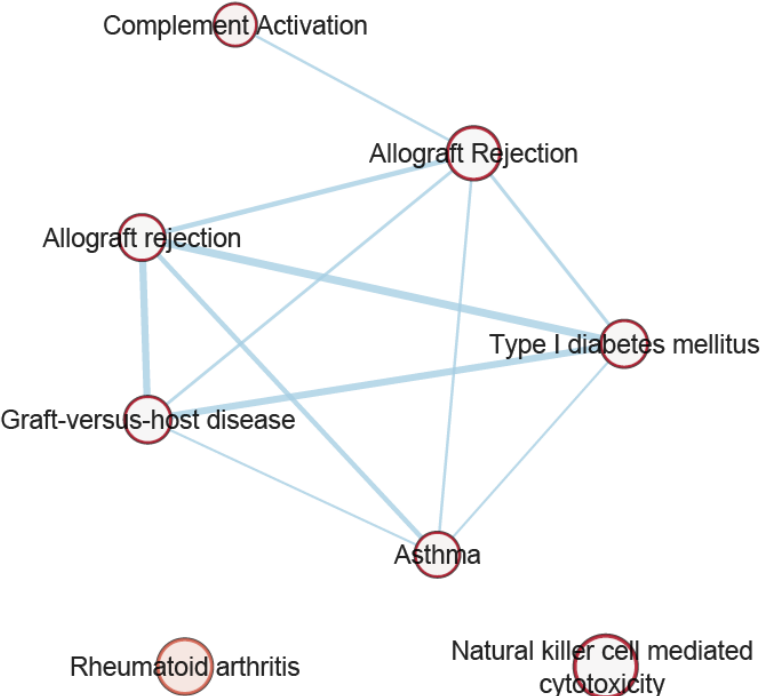
Figure 3. The network of the common pathways identified from pathway analysis. Node (circle) represents gene sets; node size represents number of genes within the gene sets; edges (connecting lines) represent overlap between gene sets; edge width represents number of genes that overlap between a pair of gene sets.